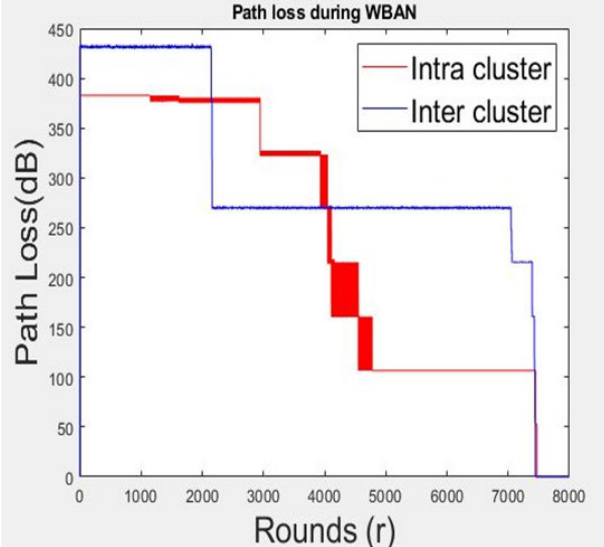
Figure 12. Path loss in WBAN